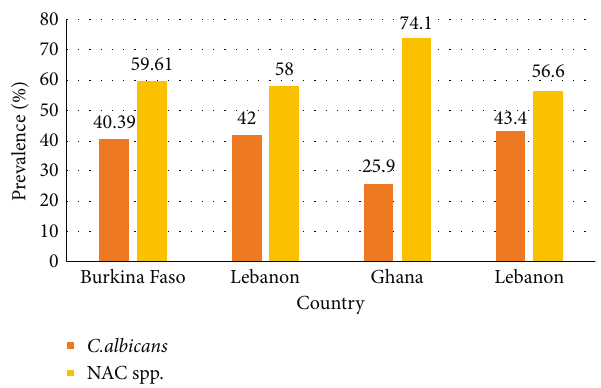
Figure 2: Di ff erence in the prevalence rates of Candida albicans and non- albicans Candida spp. in Asian and African countries. Here, dominance of non- albicans Candida spp. over Candida albicans has been